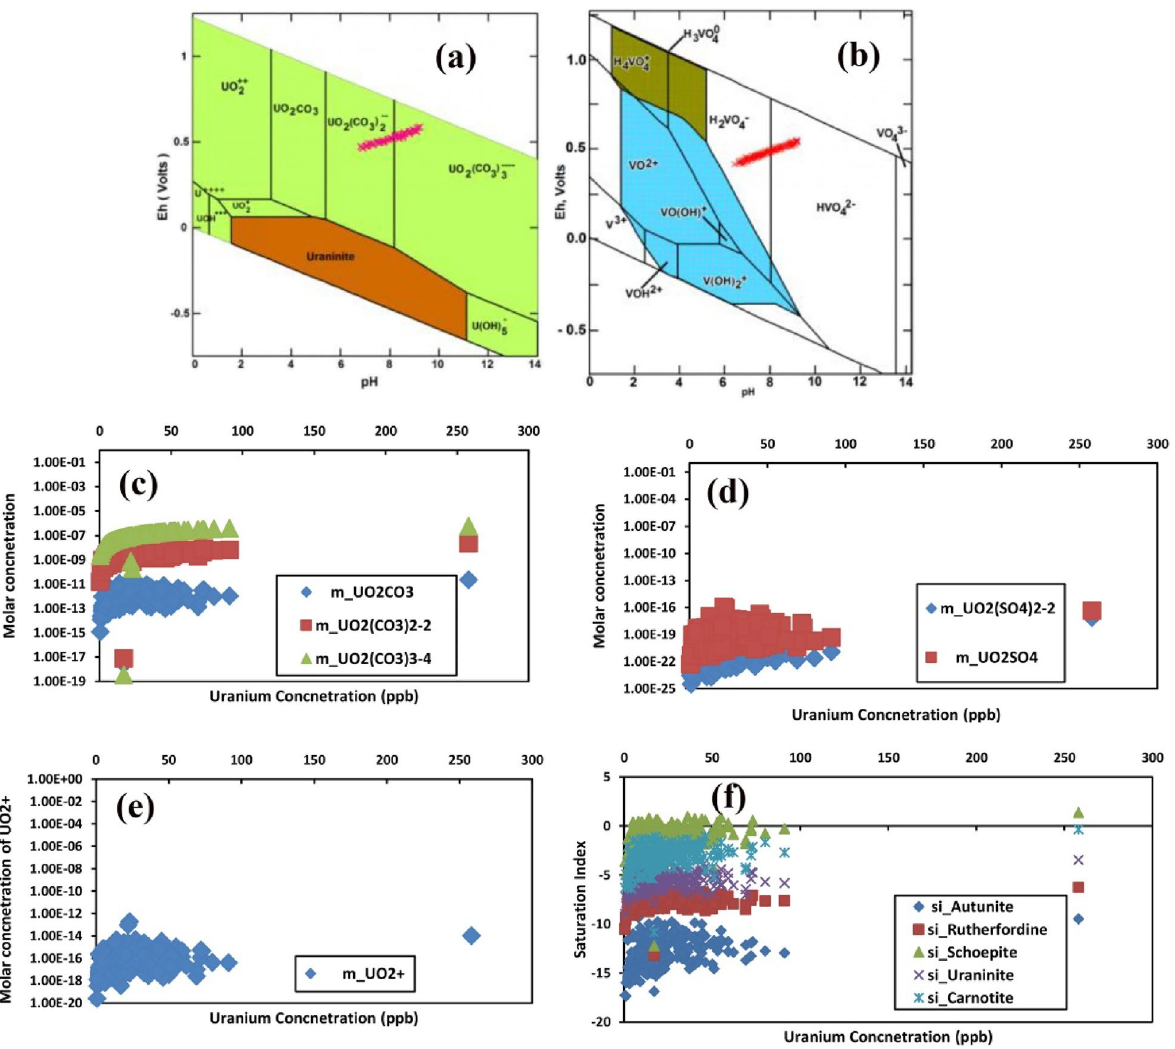
Figure 3. ( a ) The stability states of different uranyl entities, the green shades indicate the species and the brown represents the mineral and ( b ) Vandyl species, the lighter and the darker shades indicate the fields of V 4+ and V 5+ complexes, in the Eh–pH plots. Variation of the ( c ) molar concentration of uranyl carbonates species ( d ) Uranyl sulfate. species. ( e ) Uranyl oxide, with U concentration in groundwater. The species concentrations were derived from the PHREEQCI. ( f ) The relationship of the saturation index of major uranium minerals with Uranium concentration in